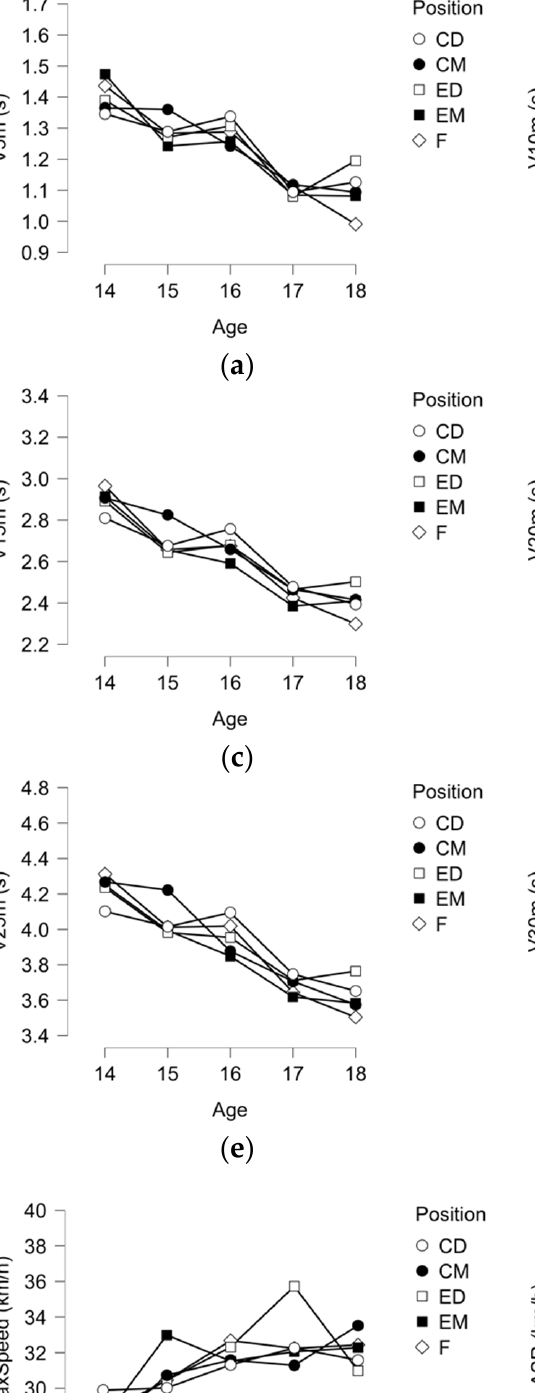
( d ) Figure 1. Descriptive plots for (a) height (cm); ( b ) body fat (%), ( c ) body mass (kg); and ( d ) CMJ (cm).